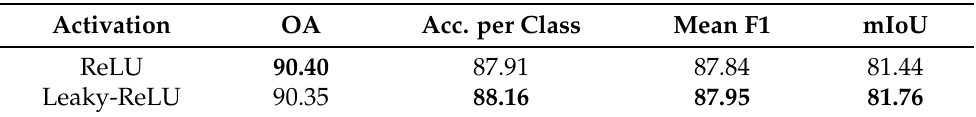
Table 7. Ablation study about activation functions: the leaky-ReLU overperforms by very little the ReLU in all the metrics, but the overall accuracy